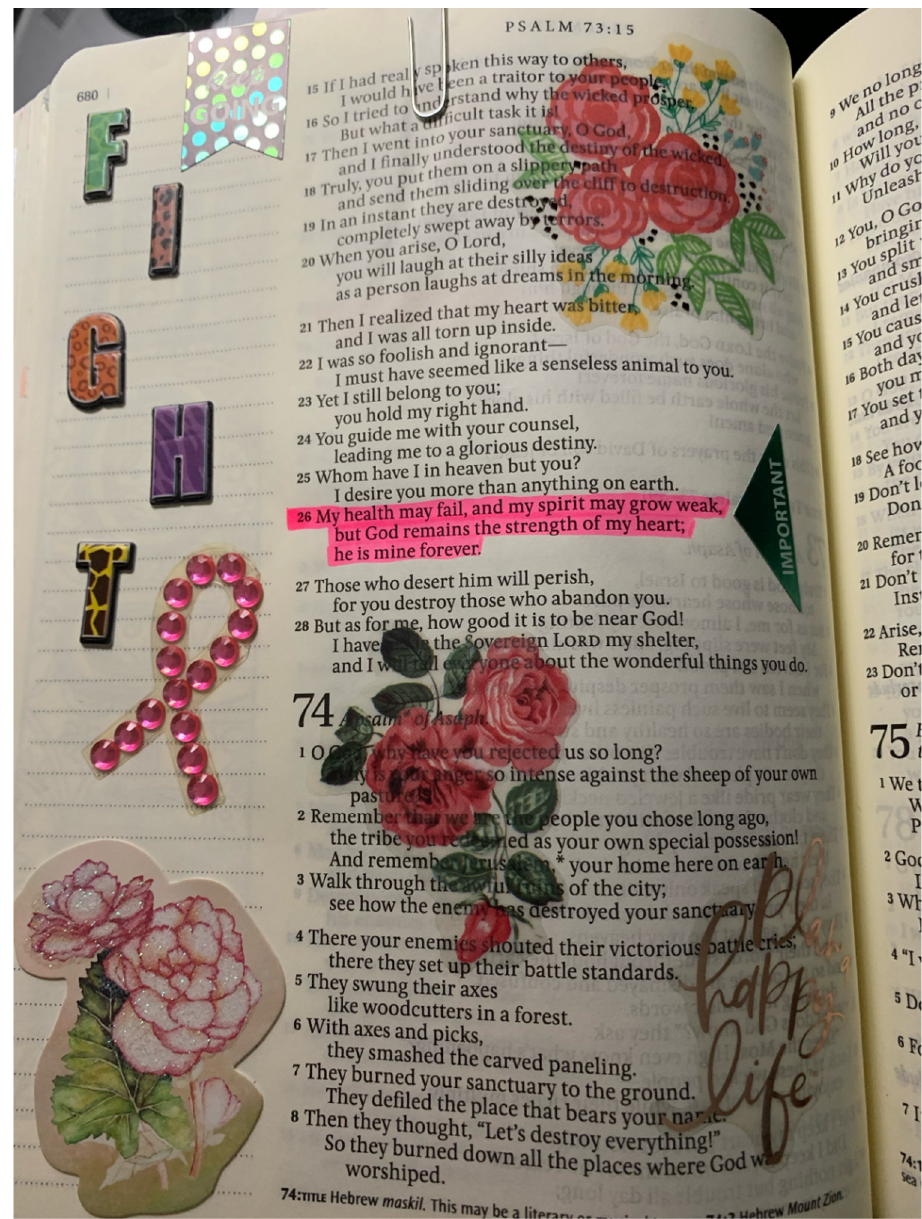
Figure 1. Psalm 73:26. With kind permission of the